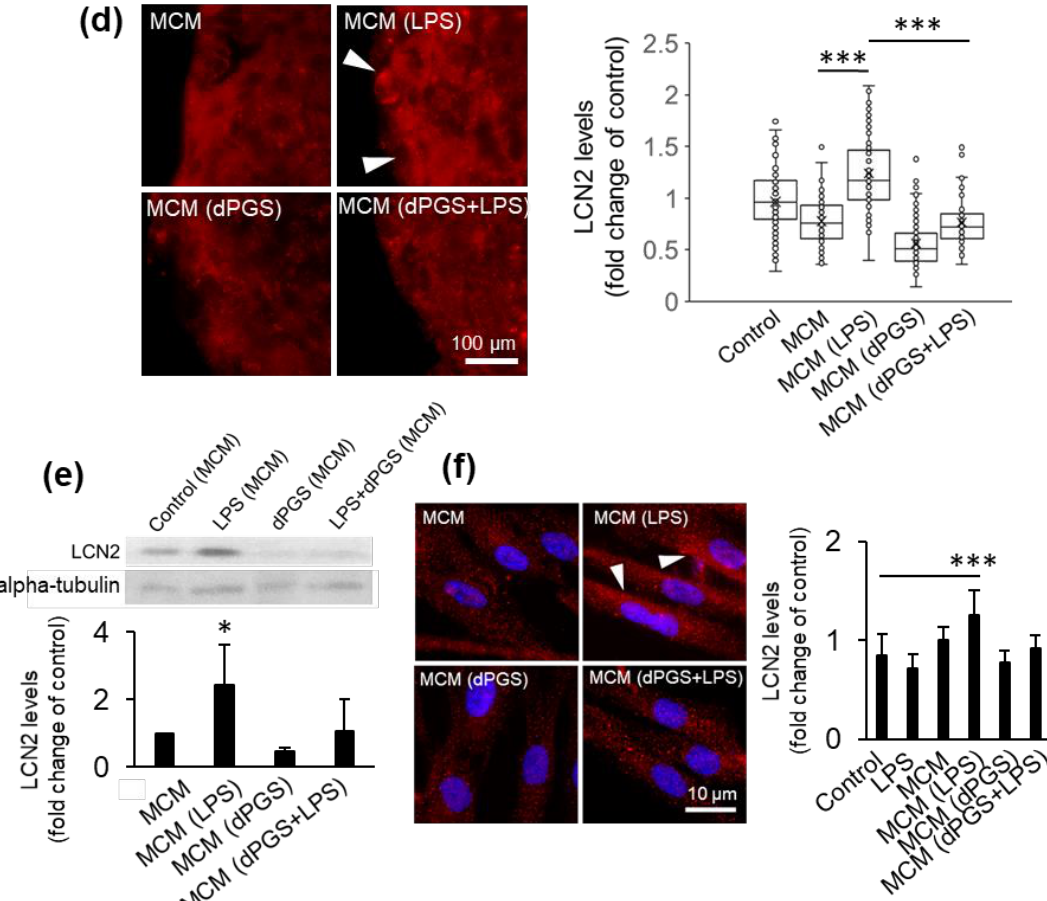
Figure 2. Lipocalin-2 levels in human cerebral organoids. ( a ) Micrographs of lipocalin-2 (LCN2) detected by immunofluorescence in organoid cryosections following treatment with LPS (10 ng / mL) for 24 h. Astrocytes were labeled with GFAP and nuclei with Hoechst 33342. The negative control was prepared in the absence of primary antibodies to account for background fluorescence. Samples were imaged using a fluorescence microscope. ( b ) LCN2 levels in organoids treated with lipopolysaccharide (LPS) (10 ng / mL) with or without dPG (1 µ M) and dPGS (1 µ M) for 24 h and measured by Western blot, with beta-actin as loading control. Quantification shown are the average intracellular LCN2 levels ± SD in organoids based on immunofluorescence images shown in ( a ). A total of 27 samples were analyzed from three independent experiments. ( c ) Schematic representation of media conditioning from microglia used for cerebral organoid treatment. ( d ) Representative fluorescence micrographs of intracellular LCN2 levels in organoids treated with conditioned media from microglia (MCM) treated with LPS (10 ng / mL), dPGS (1 µ M) for 24 h. Quantifications show the average and single-cell levels of LCN2 fluorescence in cryosections. A total of 1017 cells were analyzed from independent experiments. *** p < 0.001 ( e ) LCN2 levels from organoids treated as in ( d ) and measured by Western blot, with alpha-tubulin as loading control. Shown are the average LCN2 levels from two independent experiments. * p < 0.05 ( f ) Fluorescence micrographs of LCN2 abundance in primary human astrocytes treated as in ( d ) and measured using immunocytochemistry. Shown are the average intracellular LCN2 levels in astrocytes as fold increase of the untreated control. A total of 477 cells from two independent experiments were analyzed. *** p <